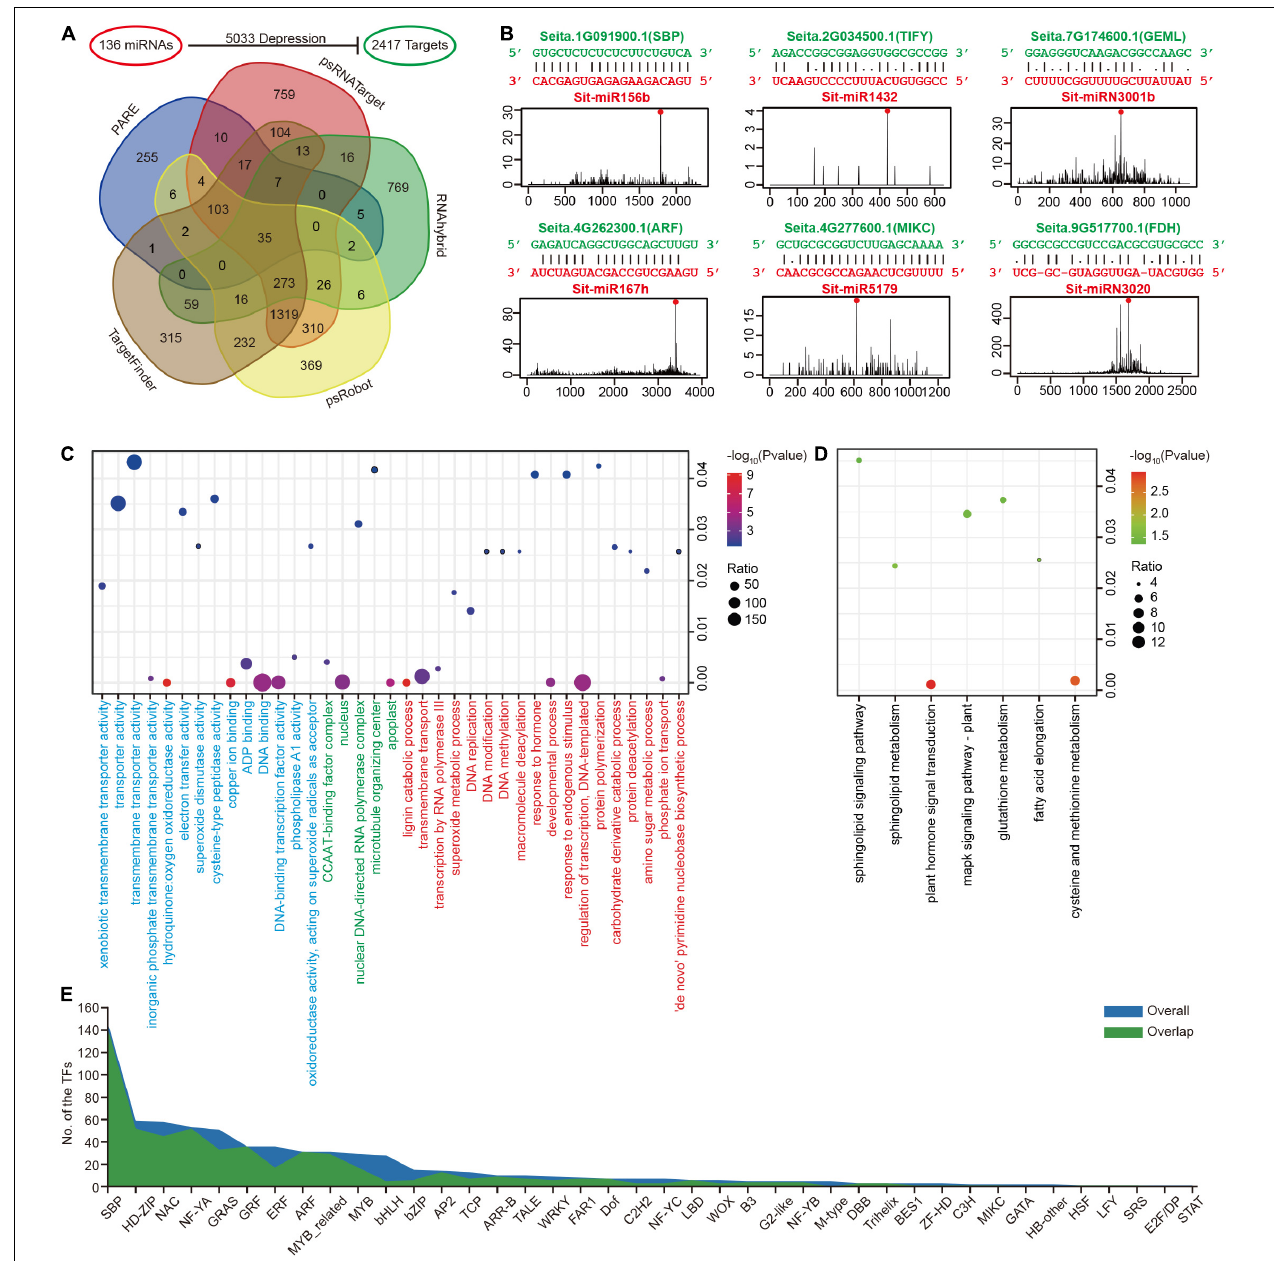
FIGURE 3 | Prediction of miRNA target genes in foxtail millet. (A) Candidate miRNA target genes predicted through five methods. (B) Six miRNA-target examples represented conserved (Sit-miR156b, Sit-miR167h, and their targets), Poaceae-specific (Sit-miR1432, Sit-miR5179, and their targets), and foxtail millet-specific (Sit-miRN3001b, SitmiRN3020, and their targets) examples. (C) Bubble chart of the GO enrichment analysis for miRNA targets. Terms of BP, CC, and MF are labeled red, green, and blue, respectively. (D) Bubble chart of the KEGG enrichment analysis for miRNA targets. (E) The numbers of transcriptional factor families accounted in the miRNA targets. The “overall” and “overlap” are the overall target genes dataset and overlap target genes dataset,